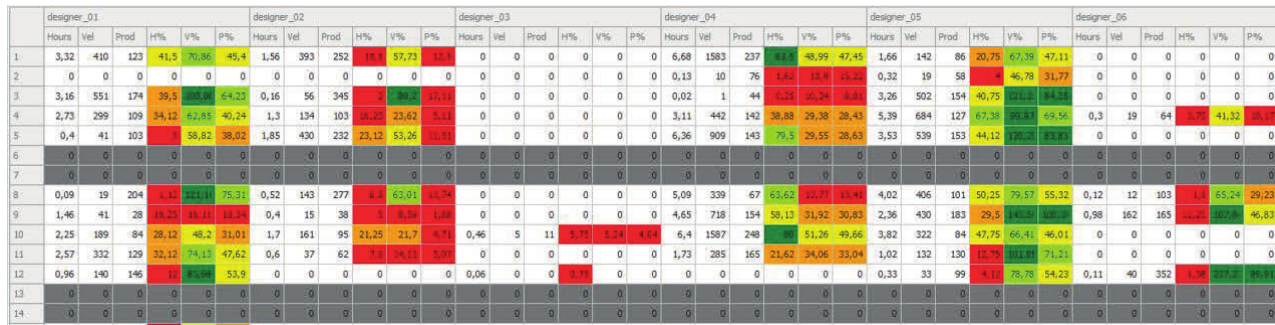
Fig. 3. An overview of the same workweek for two different designers with contextual colouring of blocks enabled .